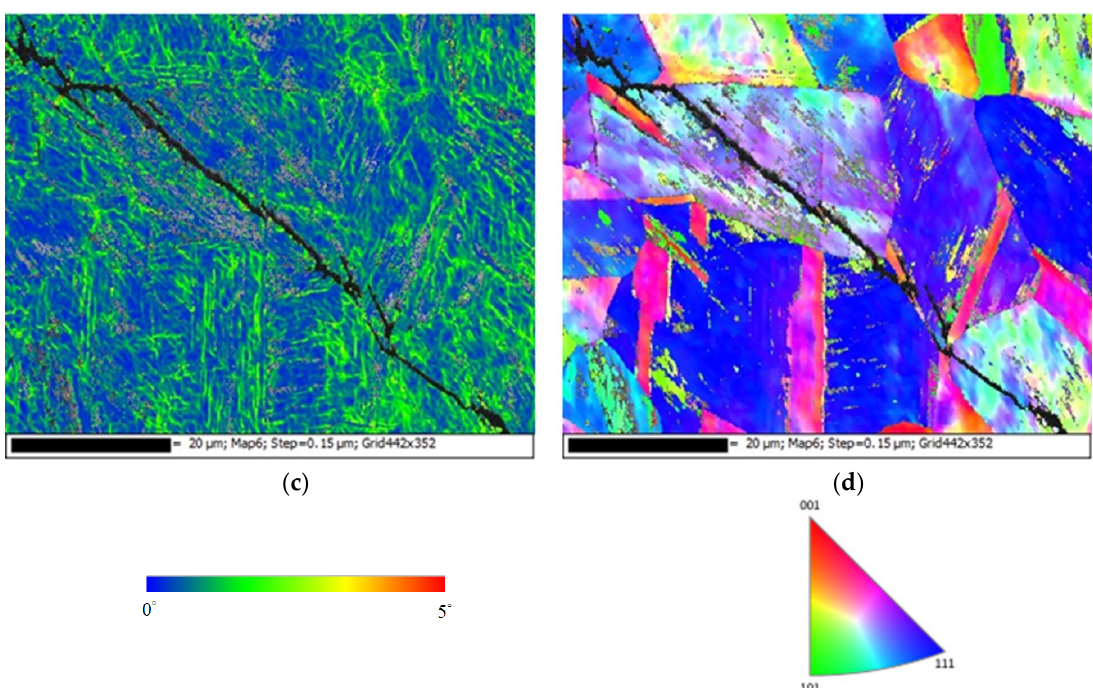
Figure 10. EBSD maps for the crack region after 5000 h tests with 1 g / m 2 chloride concentration and relative humidity of 70%. ( a ) Band contrast image, ( b ) Euler map, ( c ) KAM map, and ( d ) IPF